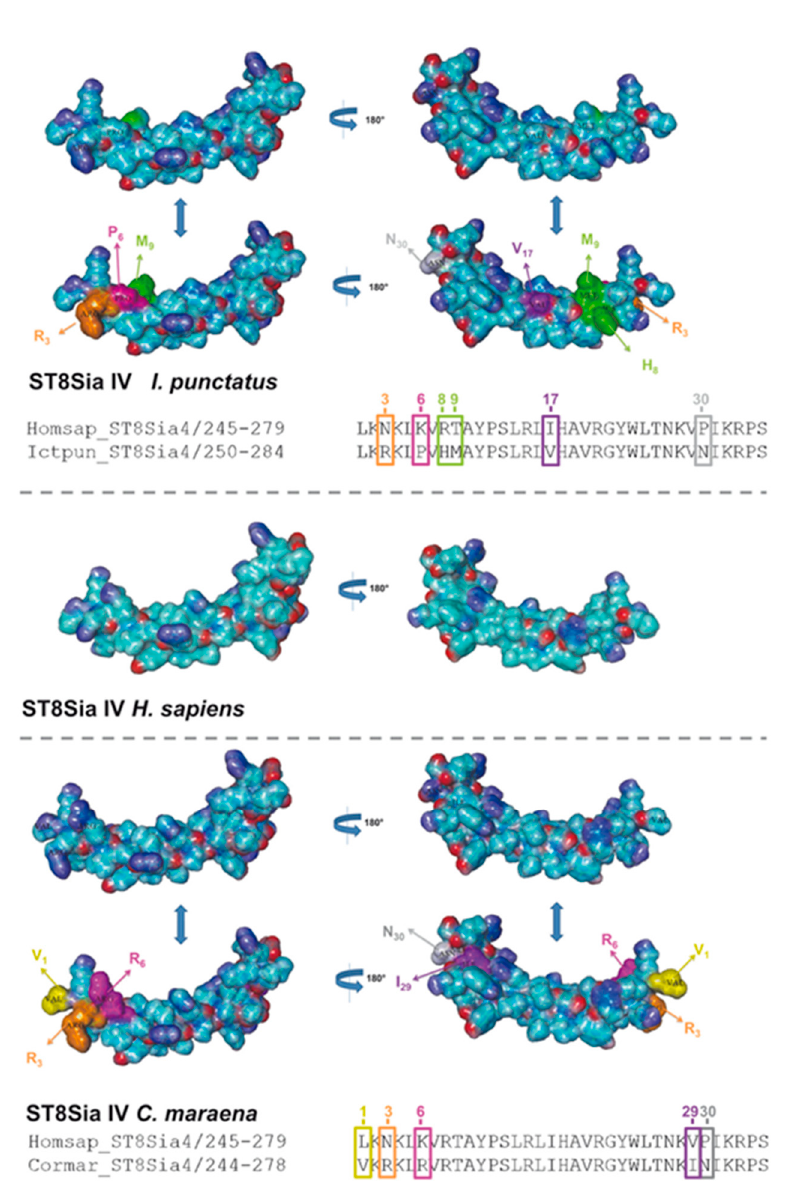
Figure 7. Three-dimensional (3D) structure of PSTD motifs in fish ST8Sia IV. The 3D model of human ST8Sia IV PSTD (Protein Data Bank entry 6AHZ)—electrostatic potential surfaces—is displayed